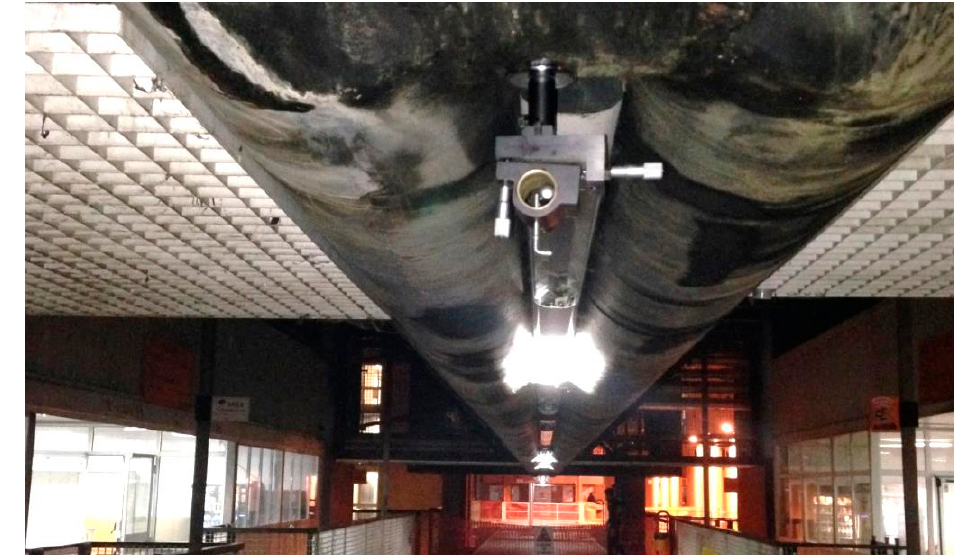
Figure 7. The pedestrian deck: the target is on the front wall.